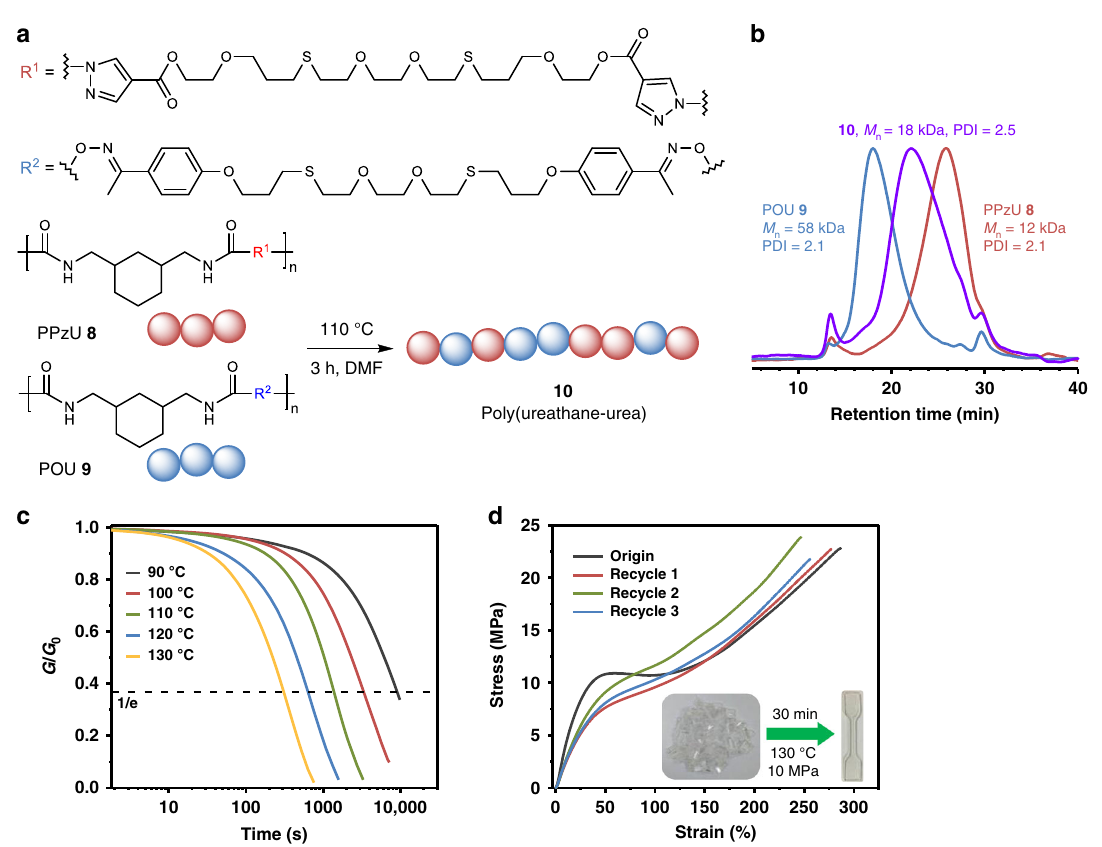
Fig. 5 Thermal reversibility of poly(pyrazole – ureas). a Macromolecular interchange reaction of PPzU 8 and POU 9 monitored by ( b ) gel permeation chromatography. c Normalized stress-relaxation analysis of PPzU 7c . d Recyclability of PPzU 7c evaluated by tensile test (the inset shows compression molding of 7c